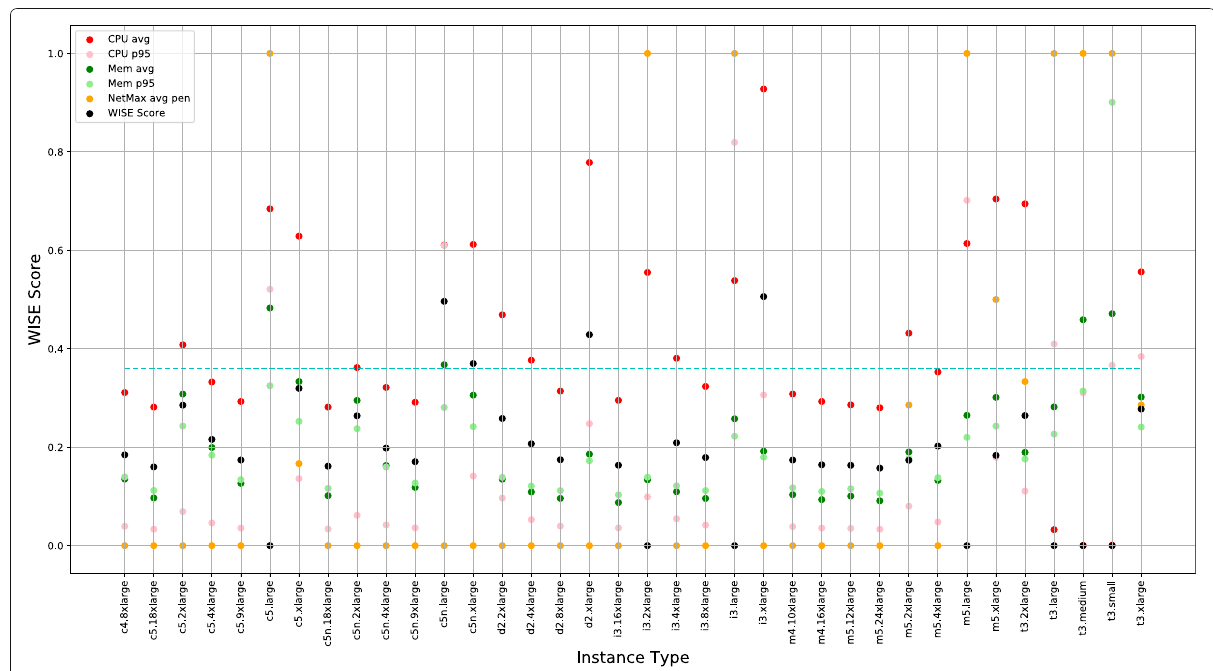
Resulting in instances that are capable of handling the load without being over-provisioned. WISE